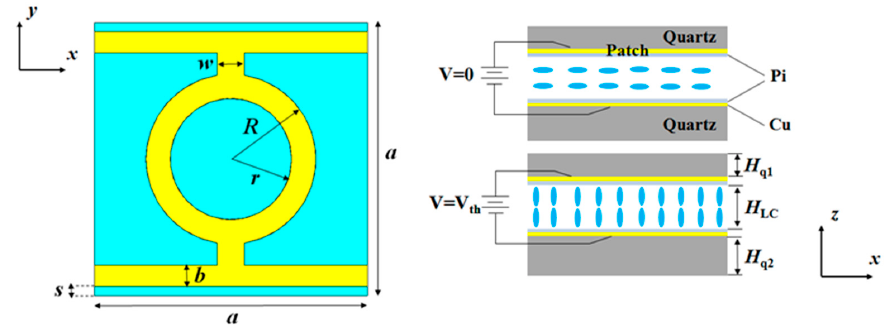
Figure 1. Schematic diagram of a metamaterial absorber based on liquid crystal (LC).